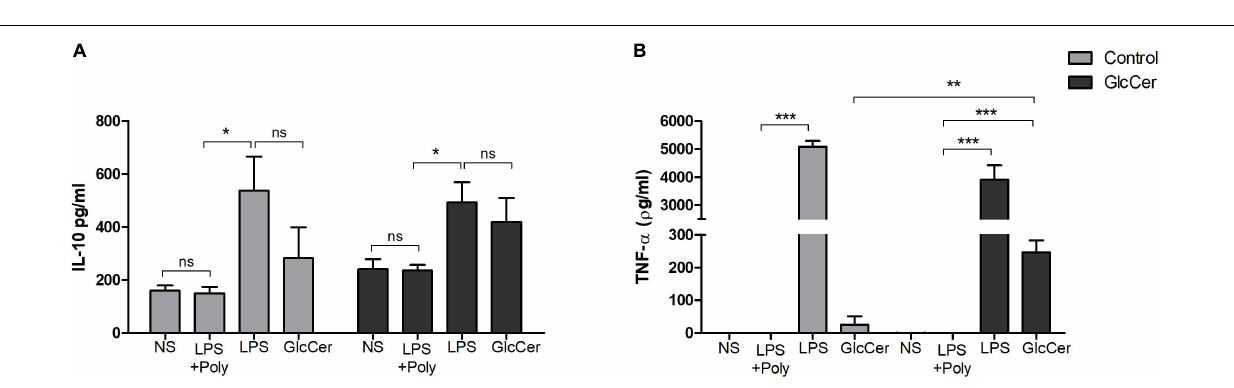
immunity, activating the macrophage. GlcCer species would then serve as the second signal and induce secretion of TNF- α by peritoneal